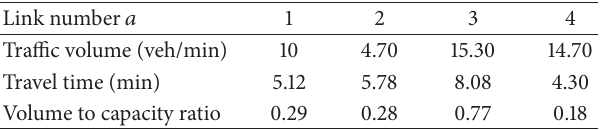
Table 3: Solution of total travel time minimization with both signal and pricing.